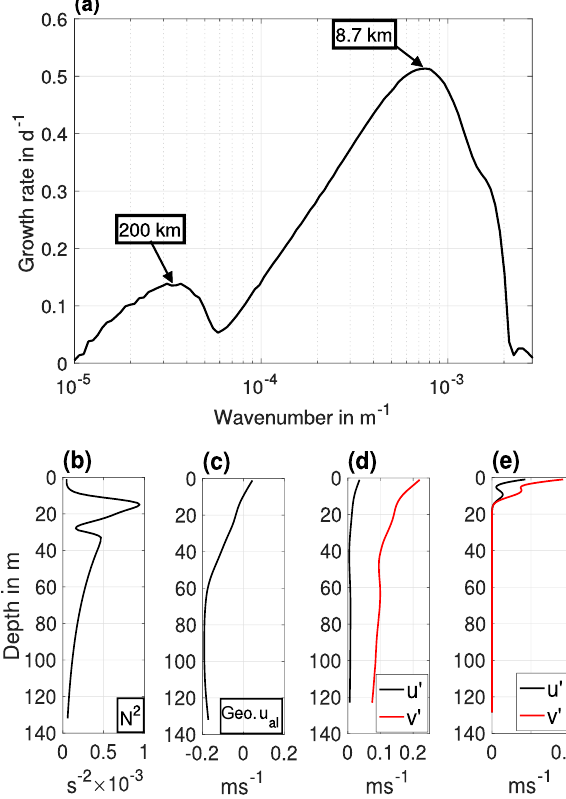
G Figure 10. (a) Initial growth rate of baroclinic instabilities obtained from linear stability analysis, applied to the frontal state during the CTD section (transect A). The local maxima of the growth rate are labeled by their corresponding length scale in kilometers. The smoothed stratification and geostrophic along-frontal velocity pro- files used as the background state are shown in panels (b) and (c) . A deep mode at large horizontal scales (200km) and a shallow mode, associated with mixed-layer instabilities and short horizontal length scales (8.7km), are present. The corresponding anomalies for the cross-front ( u ) and along-front ( v ) velocities are shown in panels (d) and (e) for the deep and shallow modes,